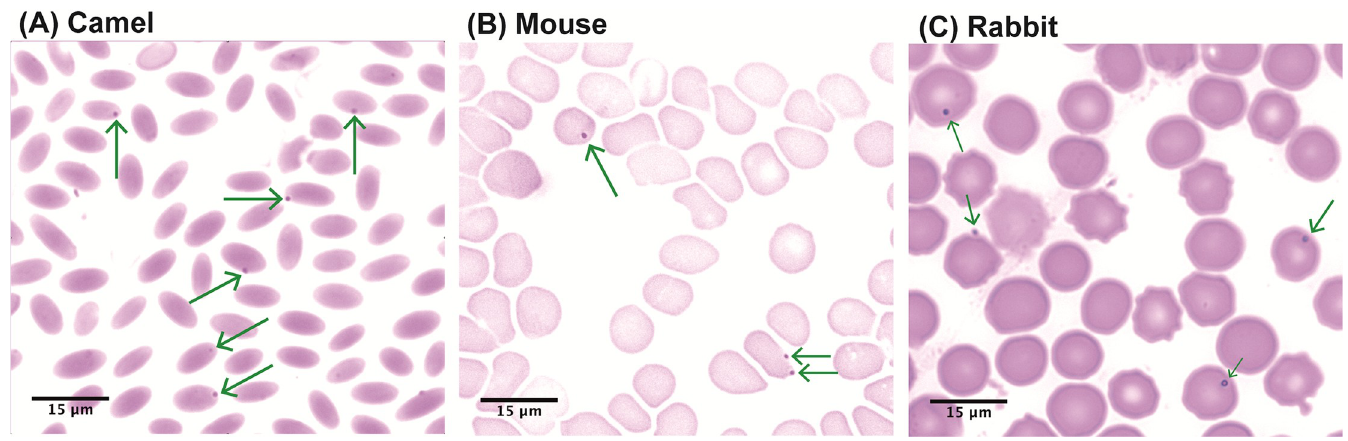
Fig 4. Field’s staining showing Anaplasma sp. infections in representative thin film blood smears. (A) Naturally infected dromedary camel, (B) Experimental mouse exposed to ked bites, (C) Experimental rabbit post-ked bites. Green arrows point to Anaplasma sp., magnification x100.